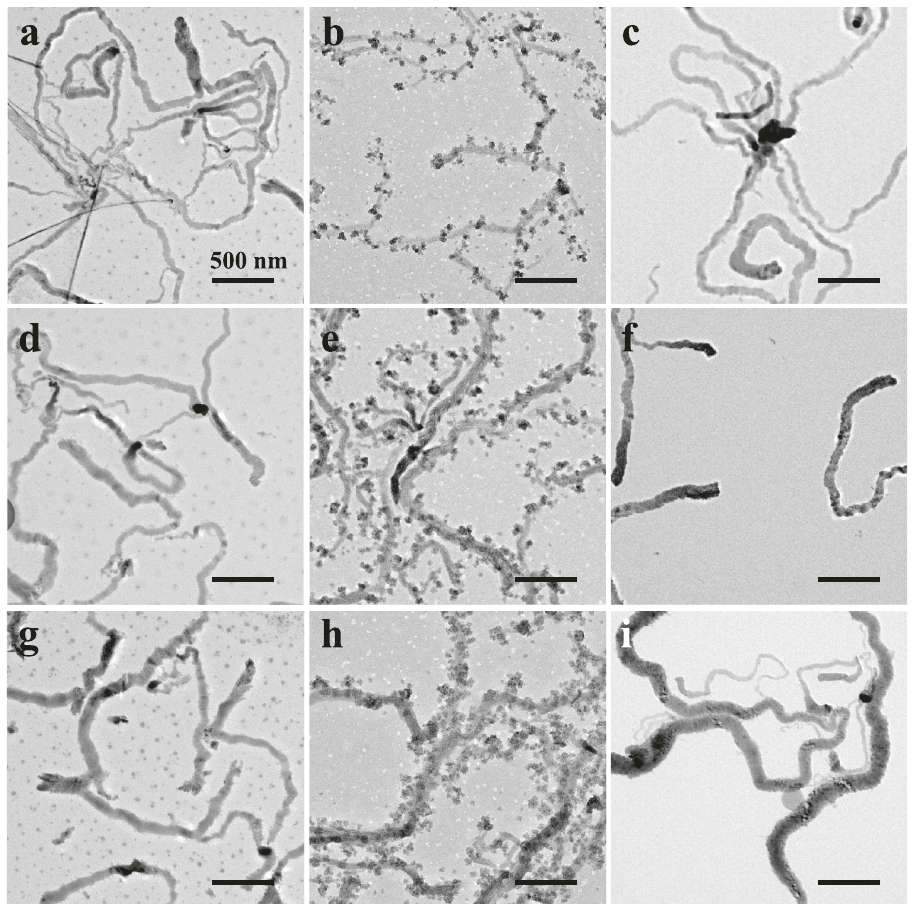
Fig. 4 The living lateral growth of cylinders by CD-FIPA. a , d , and g the mixture of spherical micelles and cylinders before incubation; b , e , and h incubation at 75 °C for 60 min; c , f , and i incubation at 75 °C for 3